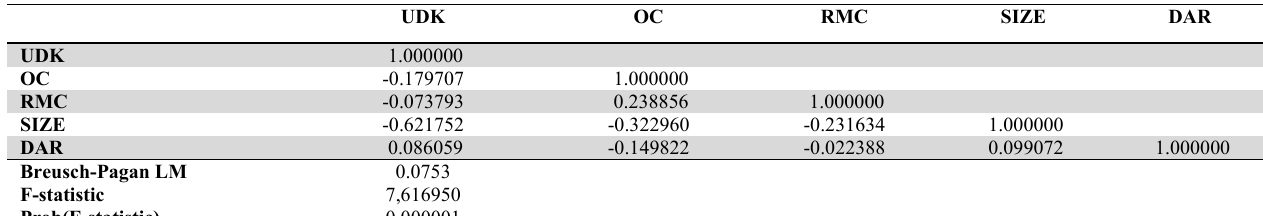
Blue Test Result